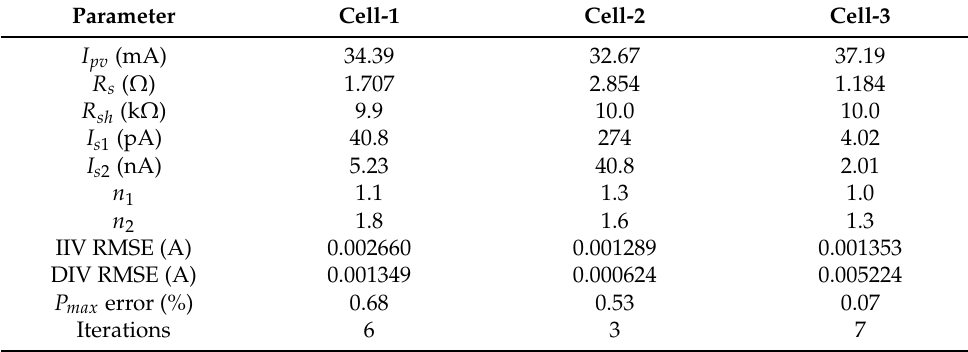
Table 4. Model parameter values.